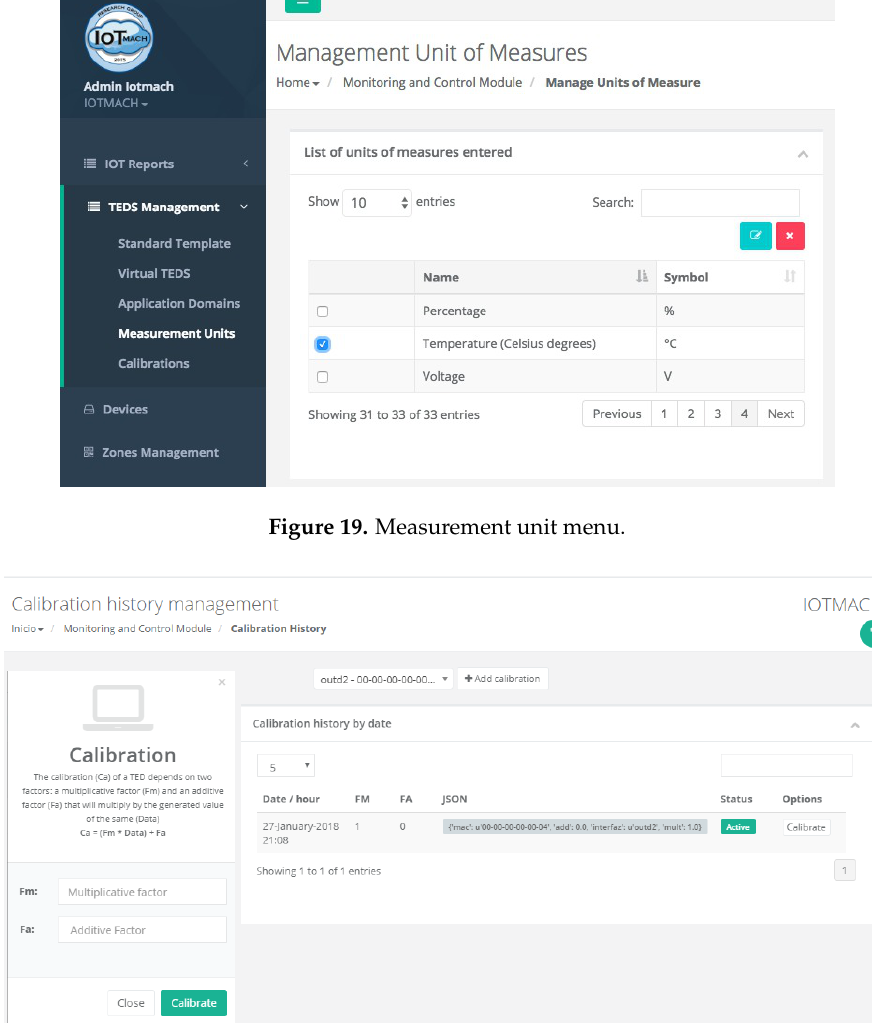
Figure 20. Calibration